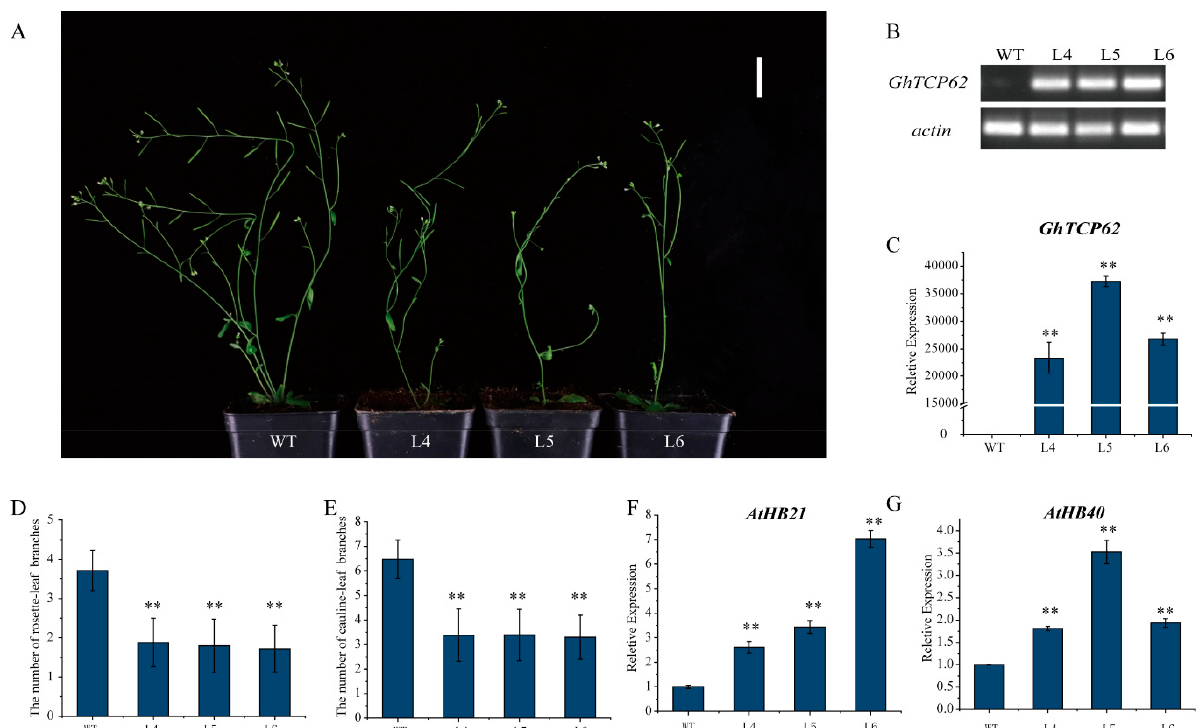
Figure 8. Overexpression of GhTCP62 in Arabidopsis reduced the number of branches. ( A ) Branching phenotypes of 35-day-old WT plants and three overexpressed 35S-GhTCP62 lines. ( B ) Semi-quantitative PCR and ( C ) the expression level of GhTCP62 in GhTCP62 overexpressed cell lines was analyzed by qRT-PCR. ( D ) Quantitative analysis of rosette-leaf branches in 35-day-old WT and GhTCP62 OE lines. ( E ) Quantitative analysis of cauline-leaf branches in 80-day-old WT and GhTCP62 OE lines. ( F ) The expression level of AtHB21 in GhTCP6 2-OE line was analyzed by qRT-PCR. ( G ) The expression level of AtHB21 in the GhTCP62 -OE line was analyzed by qRT-PCR. The error line represents the standard deviation of three repetitions. The asterisks indicated significant differences compared to WT (**P<0.01 by t- test).